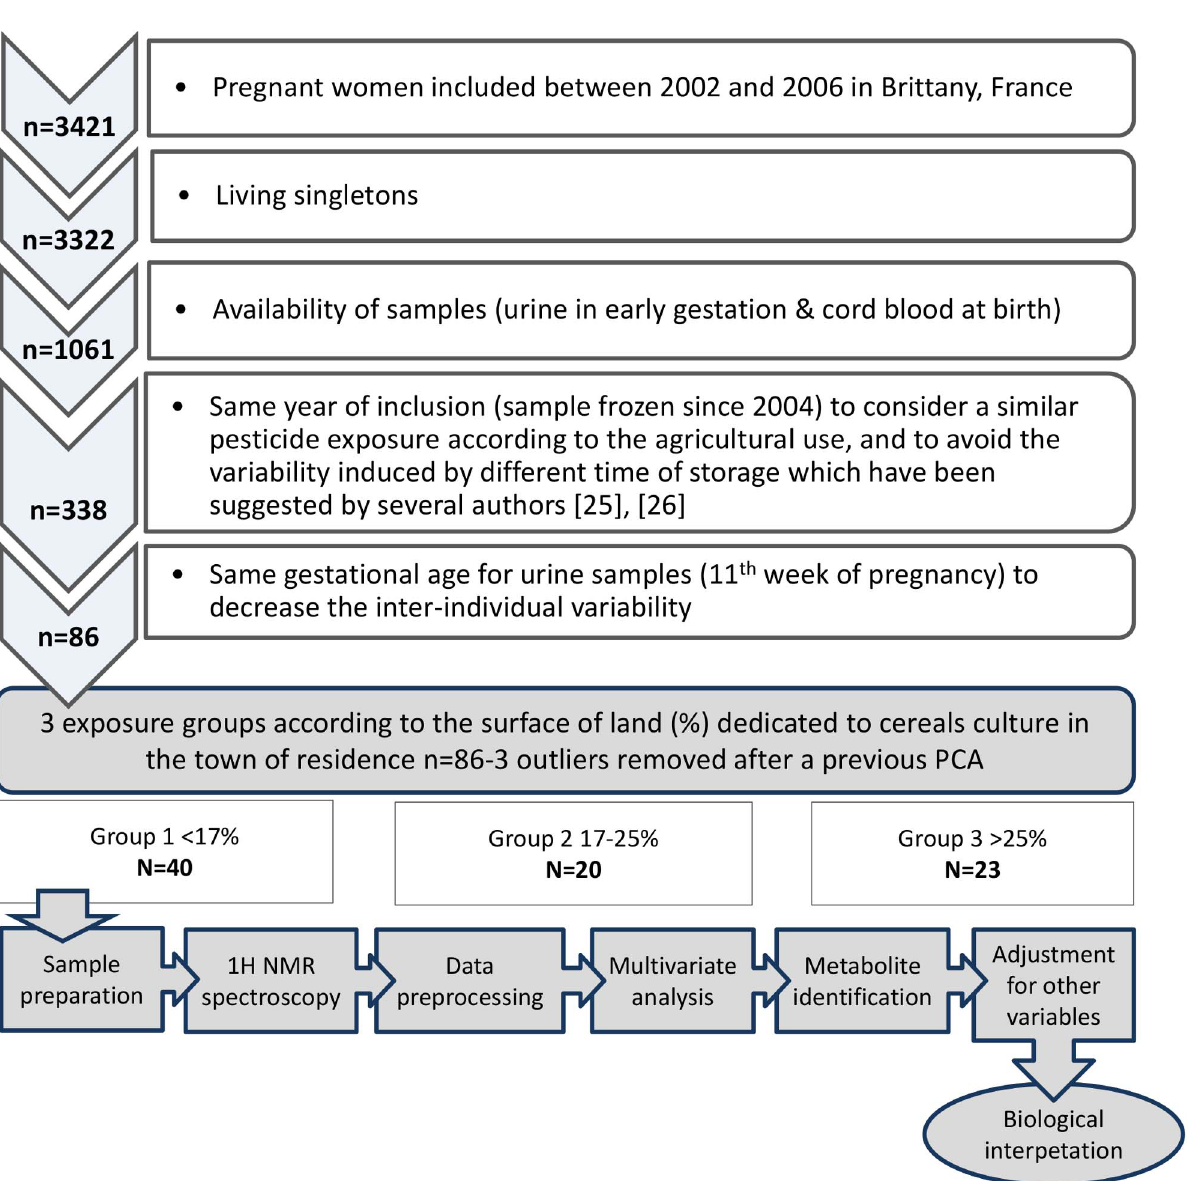
Figure 1. Flowchart of the metabolomics analysis.